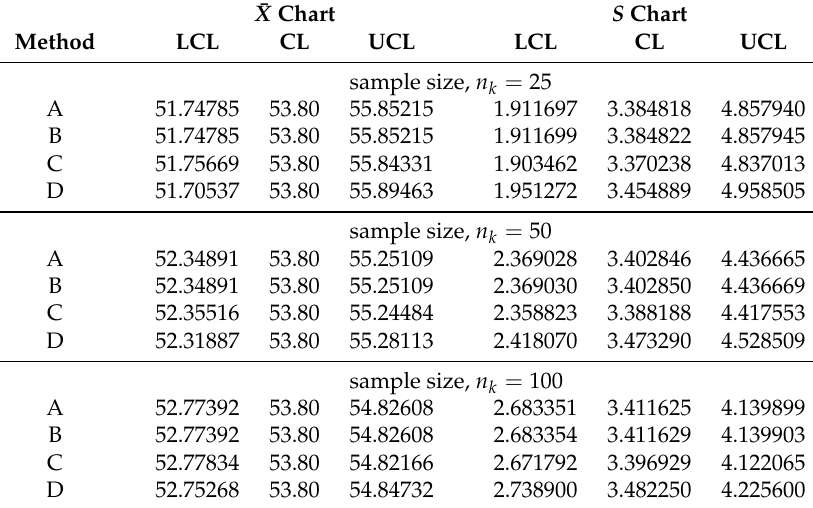
Table 4. Control limits for the ¯ X and S charts for Example 1.